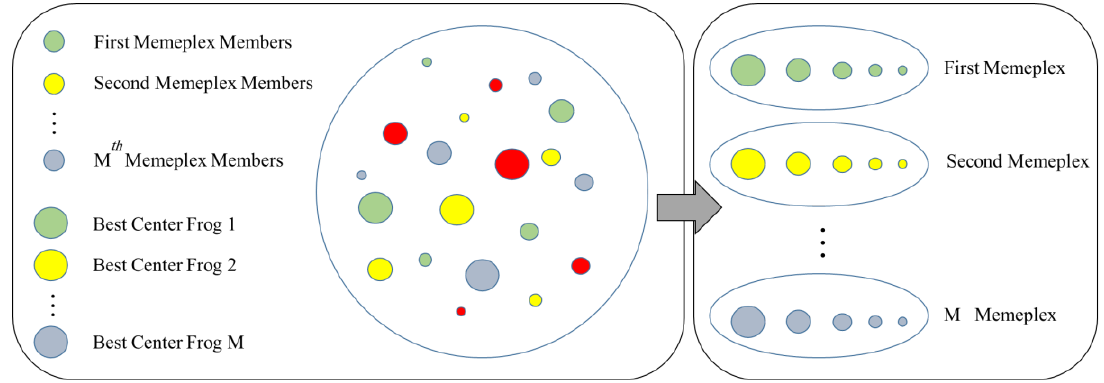
Figure 2. Leaping procedure of the shuffled frog leaping algorithm (SFLA) algorithm.